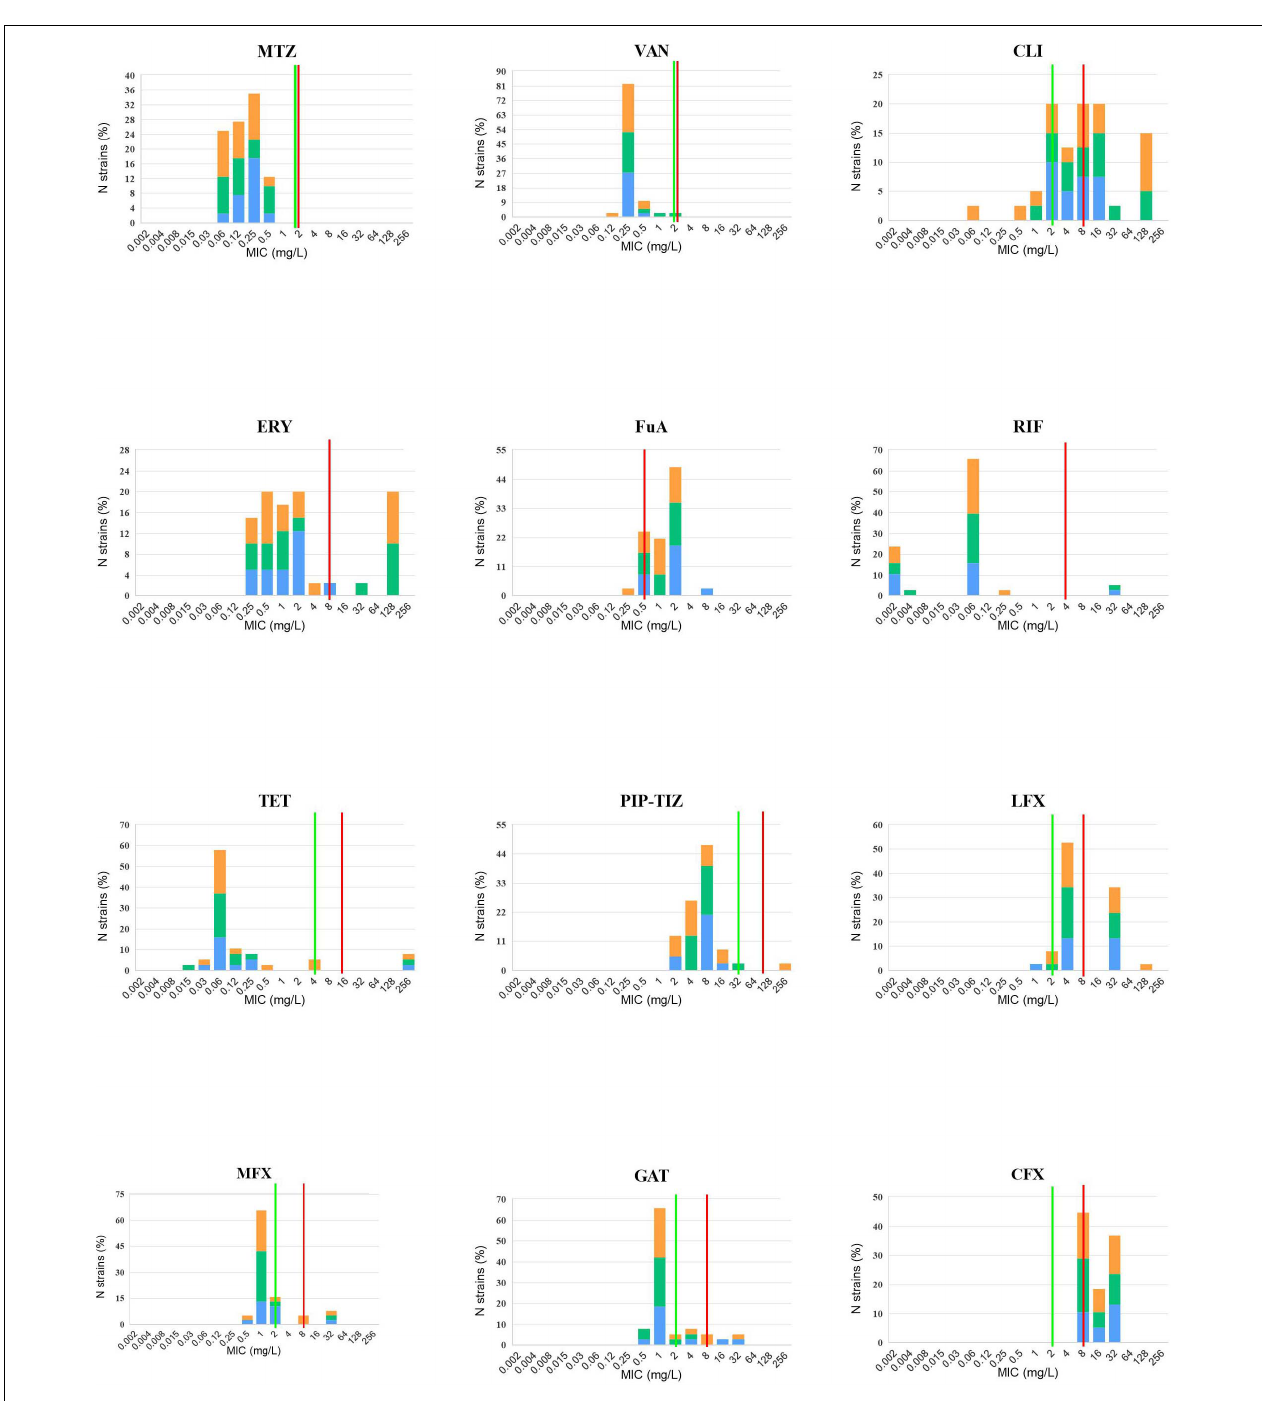
FIGURE 3 | In vitro 12 antibiotic susceptibility with susceptible and resistant breakpoints. MIC distributions for 12 antibiotic agents against 40 C. difficile isolates, orange: RT014, green: RT020, and blue: RT664, RT006, RT076, RT404, RT452, and RT587. VAN, vancomycin; MTZ, metronidazole; ERY, erythromycin; CLI, Clindamycin; RIF, rifaximin; TET, tetracycline; PIP-TAZ, piperacillin-tazobactam; LFX, levofloxacin; MFX, moxifloxacin; GAT, gatifloxacin; CFX, ciprofloxacin. Where available, established susceptible and resistant breakpoints were indicated by vertical green and red lines,